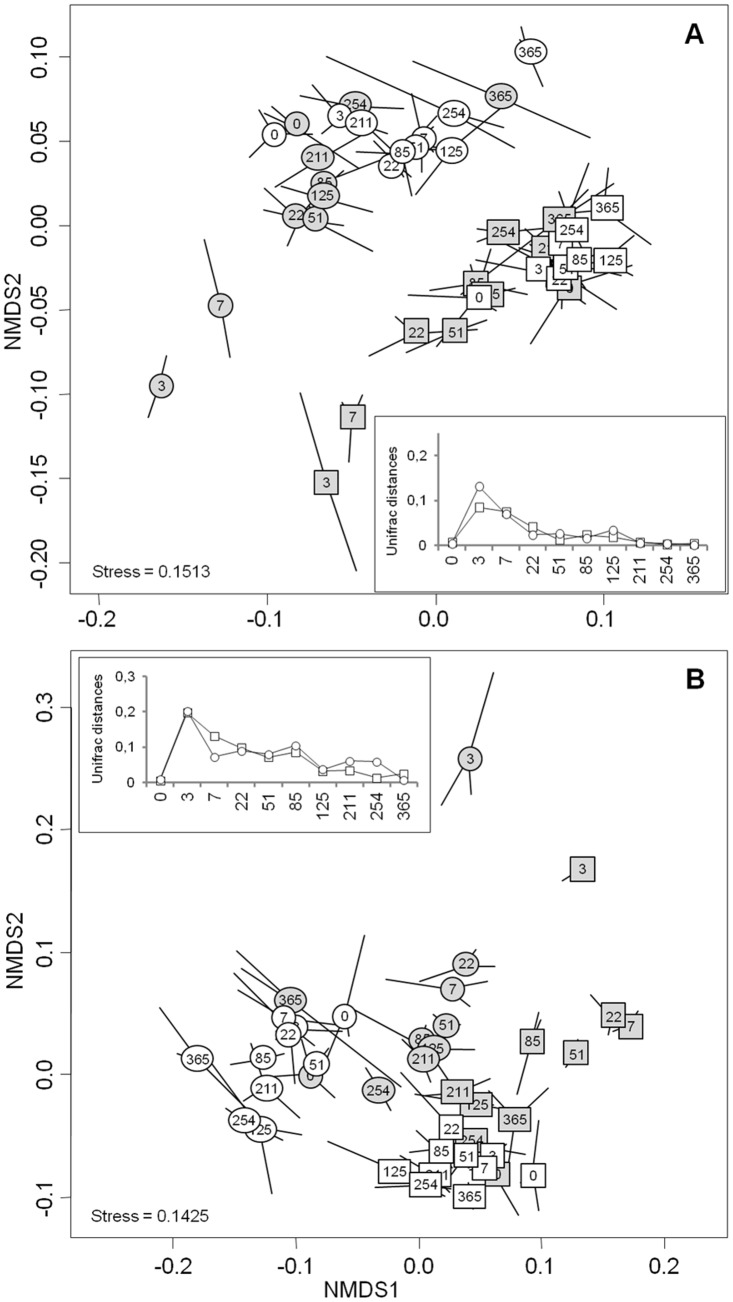
Non-metric multi-dimensional scaling (NMDS) ordination plot derived from weighted pairwise Unifrac distances for (A) bacterial and (B) fungal communities over time according to soil management history: cropland (squares) and grassland (circles).White labels represent the control treatment and grey labels represent the wheat-amended treatment. Numbers represent sampling dates and lines correspond to the three replicate samples obtained at each sampling date. Stress values for the two ordination plots were < 0.2 which indicates that these data were well-represented by the two dimensional representation. inset represents magnitude changes in Unifrac distance between the control and amended sub-plots over the year.